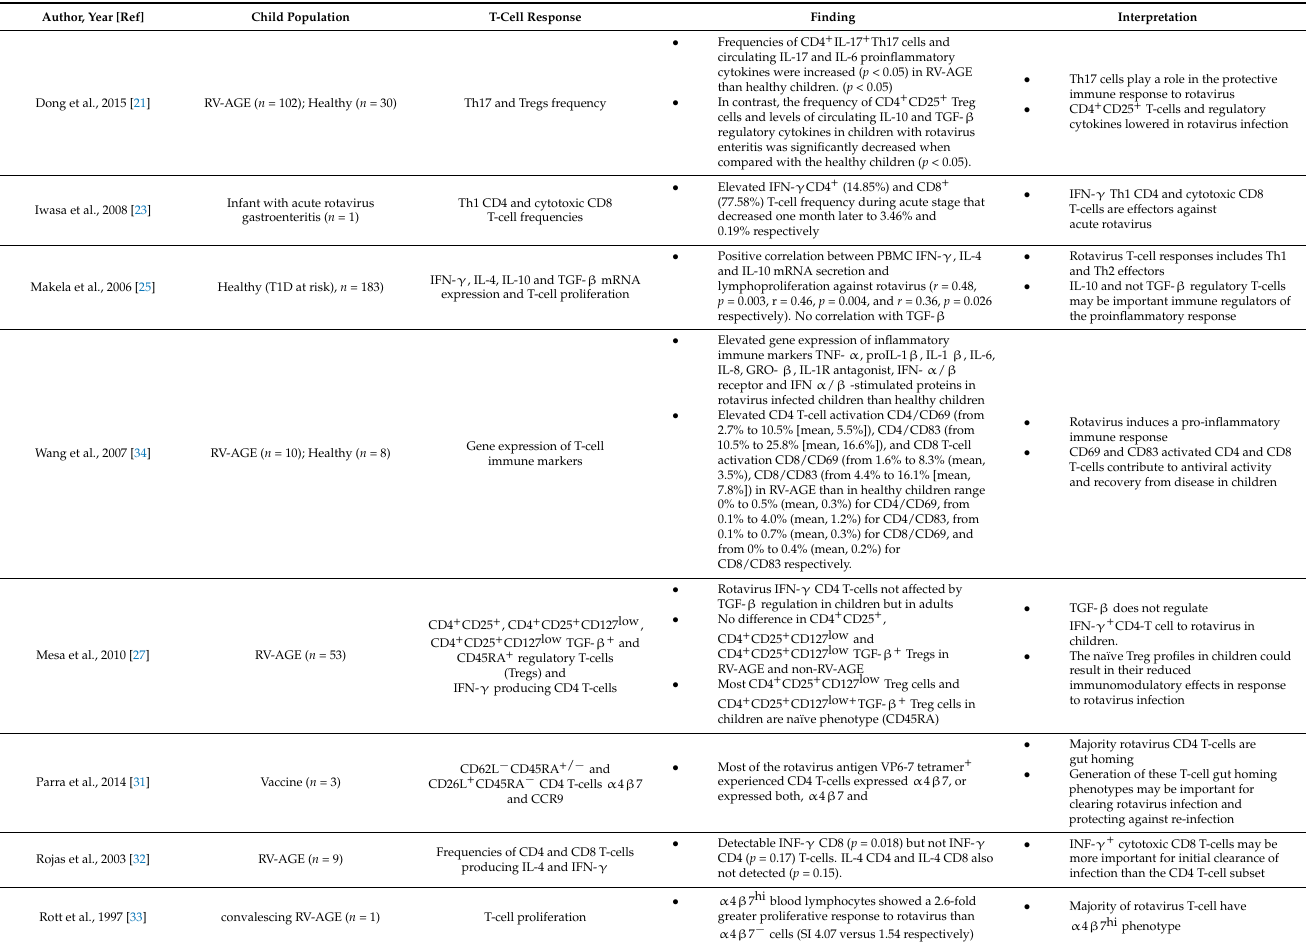
Table 5. T-cell activation, proinflammatory, regulatory and homing phenotypes in response to